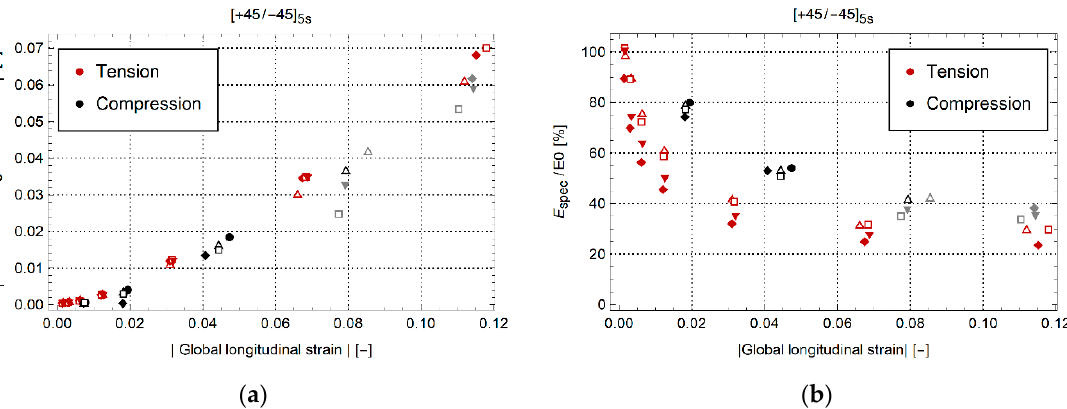
Figure 11. ( a ) Permanent strain and ( b ) evolution of normalized elastic modulus for [+45/ − 45] 5s . Datapoints in gray are measured after buckling.